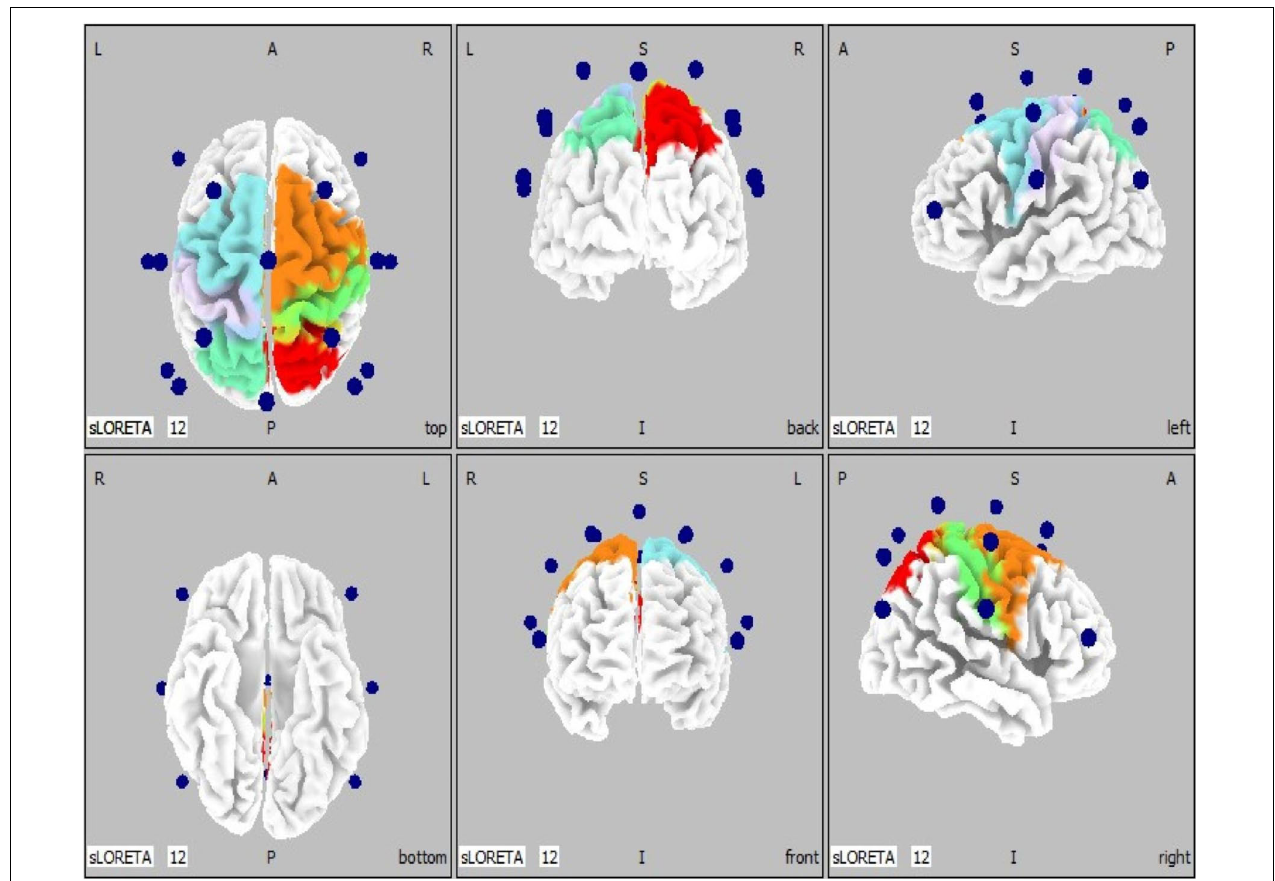
FIGURE 2 | EEG electrode locations ( n = 16, blue spheres) are shown superimposed on a generic head model (left, middle, and right panels show top/bottom, back/front, and left/right views, respectively). BA, Brodmann’s areas. Regions of interests ( n = 10) are defined as follows: ROI #1 = left BA 1-3 (primary somatosensory cortices, light purple); ROI #2 = left BA 4 (primary motor cortex, light blue); ROI #3 = left BA 5 (somatosensory association area, cyan); ROI #4 = left BA 6 (premotor cortices, light blue); ROI #5 = left BA 7 (visuomotor coordination area, cyan); ROI #6 = right BA 1-3 (primary somatosensory cortices, green); ROI #7 = right BA 4 (primary motor cortex, orange); ROI #8 = right BA 5 (somatosensory association area, red); ROI #9 = right BA 6 (premotor cortices, orange); ROI #10 = right BA 7 (visuomotor coordination area,